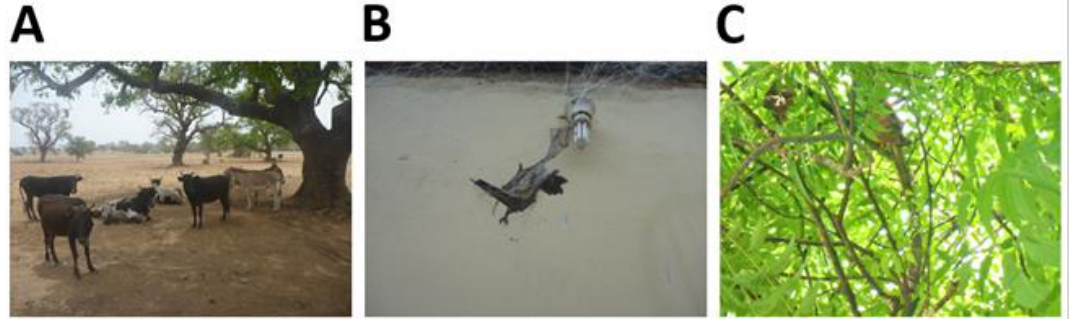
Figure 3. Free-roaming livestock under trees observed in a community in the Upper East region ( A ). A dead bat caught in a mist net close to the roof of a house in a farm in the Ashanti region ( B ). Eidolon helvum bats observed roosting in a tree at a farm site in the Volta region ( C